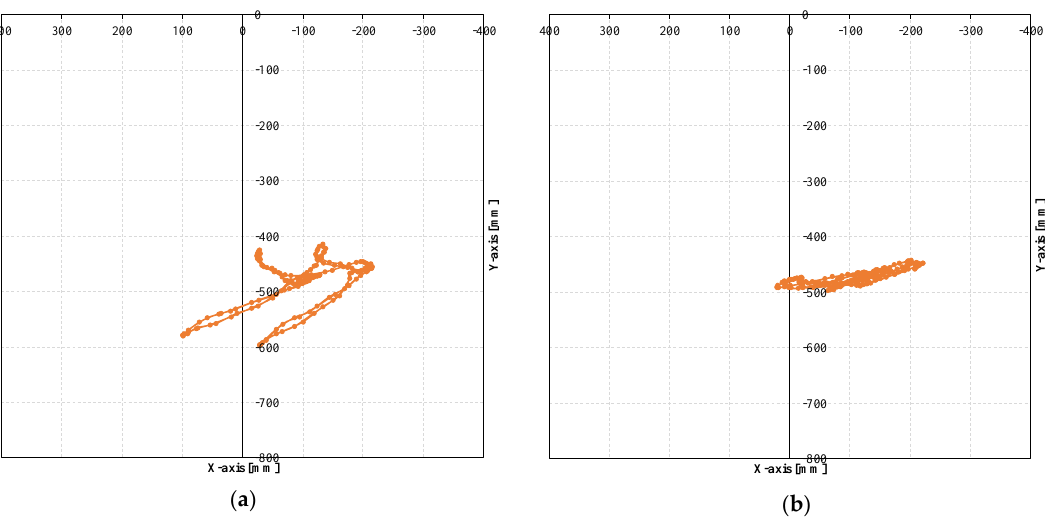
Figure 18. Trajectory of the leg tip using evaluation function 2 with 0.5 kg (( a ) first generation, ( b ) 18th generation).